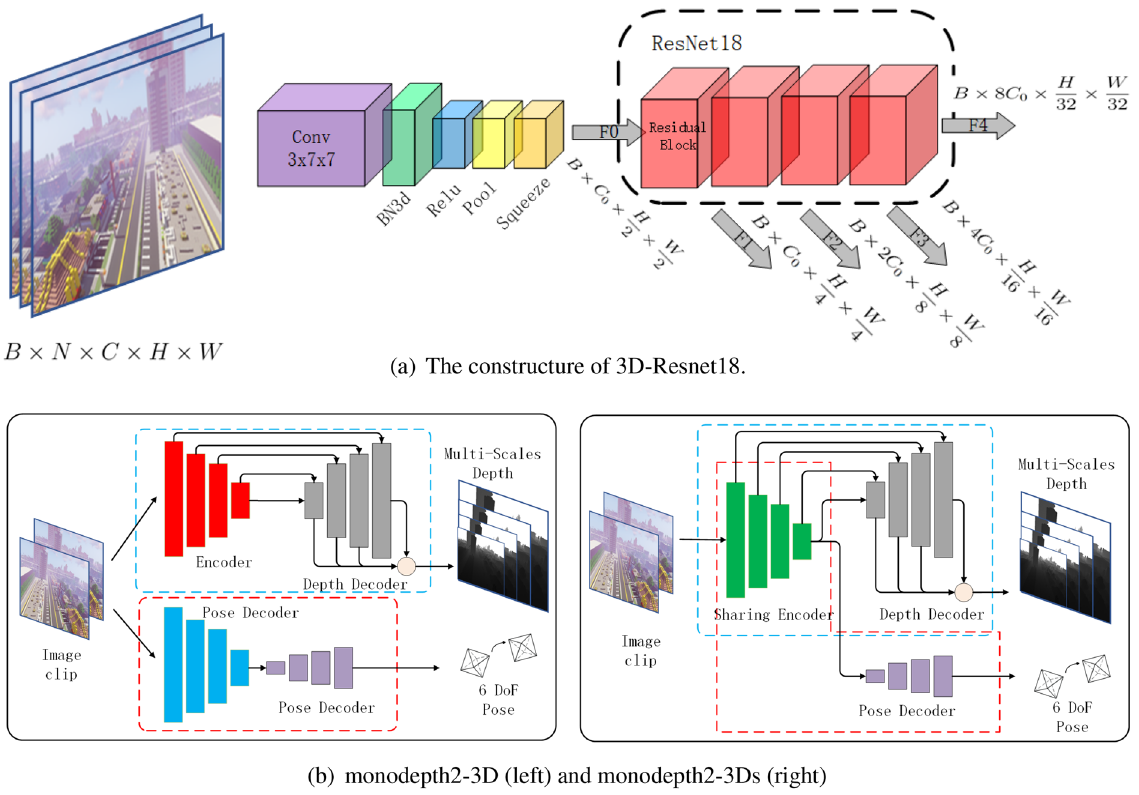
Figure 5. For spatiotemporal feature learning, We build a 3D encoder and apply it into monodepth2 to build monodepth2-3D and